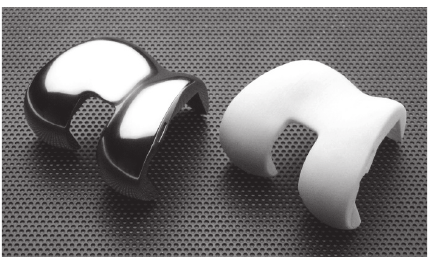
Figure 1: Left: original implant made from metal; right: “copy” made from polyamide, created by means of parameterised CAD modelling and rapid